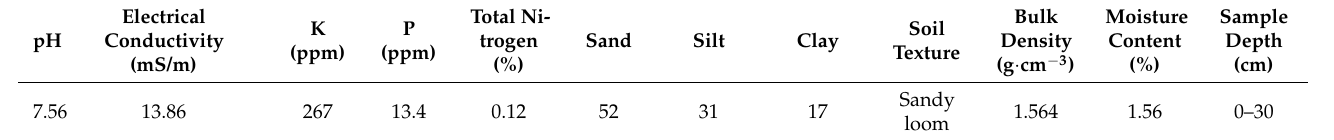
Table 1. Physical and chemical soil traits of Zanjan University’s research